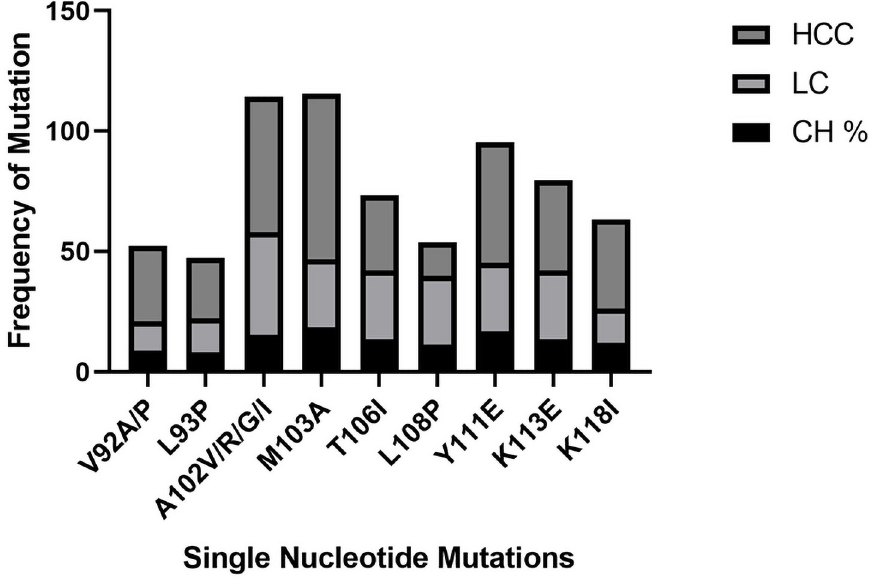
Fig 6. Frequency of single nucleotide mutations in CH, LC, and HCC